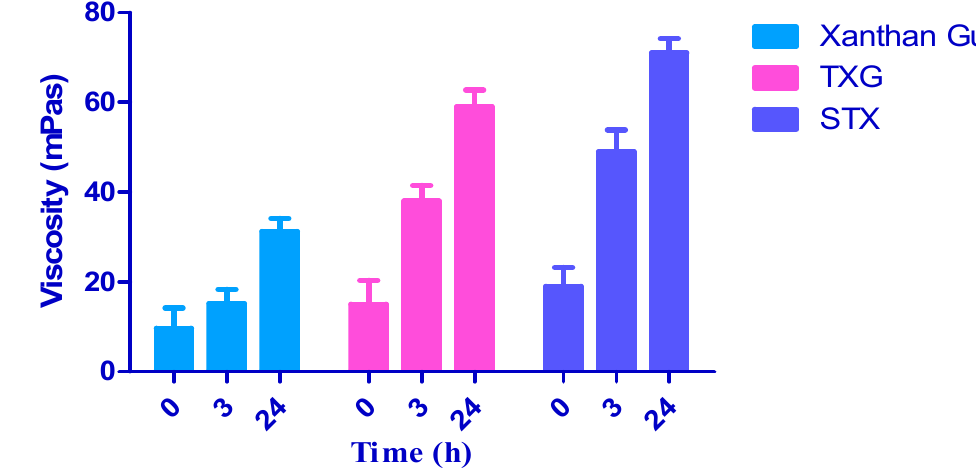
Figure 5. Rheological profile of xanthan gum, TXG, and STX. Table 6. The quantity of thiol and disulfide groups was estimated by quantitative assay.